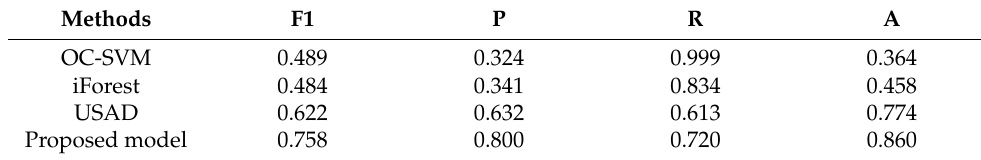
Table 8. Performance comparison of the proposed model with other methods.